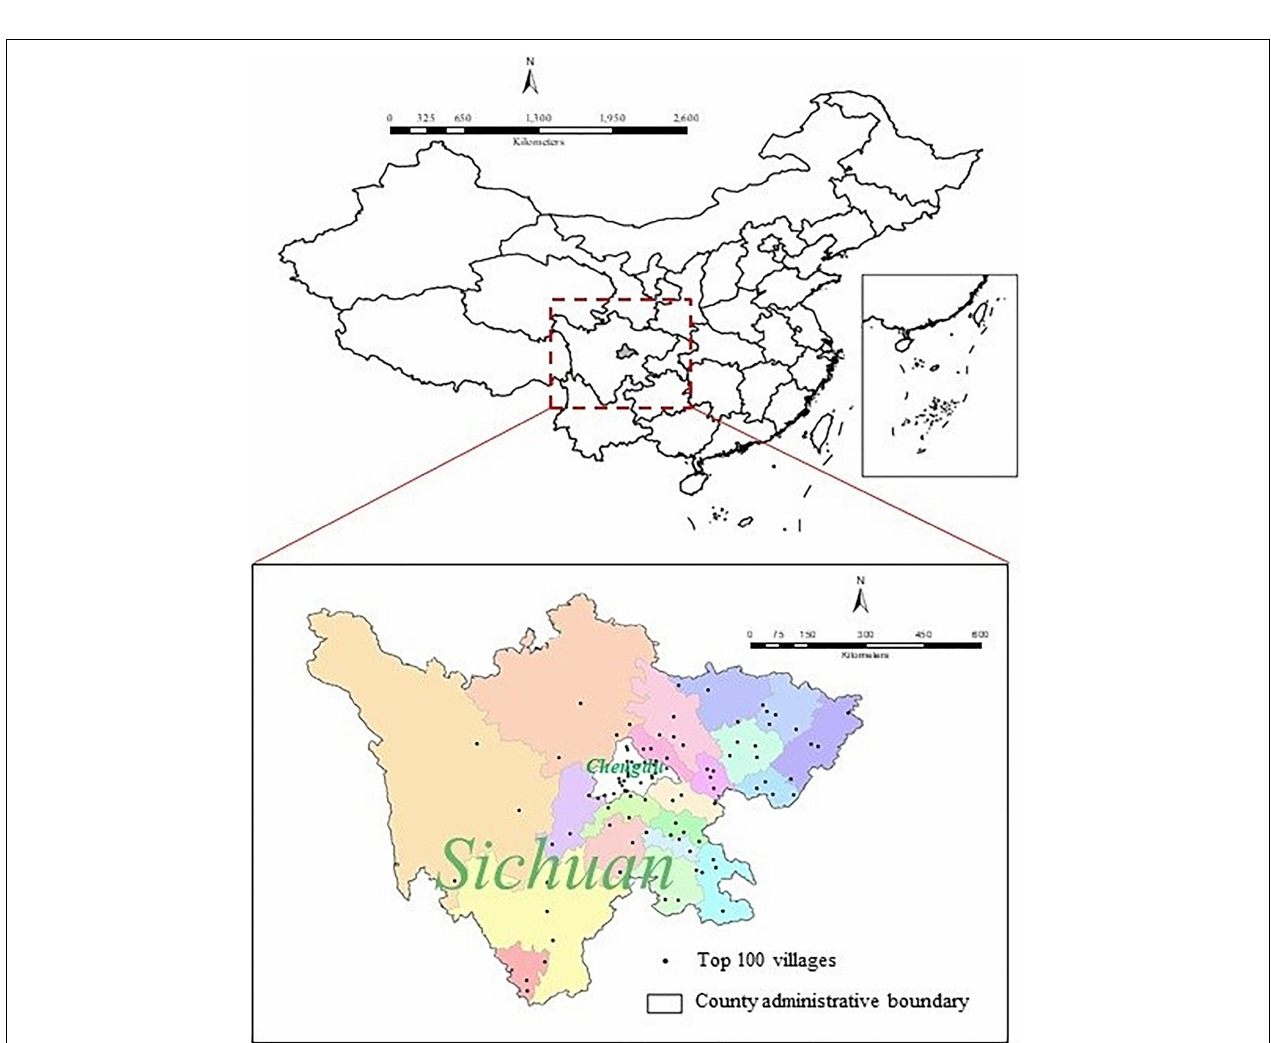
FIGURE 2 | Geographic location of top 100 villages in Sichuan Province.